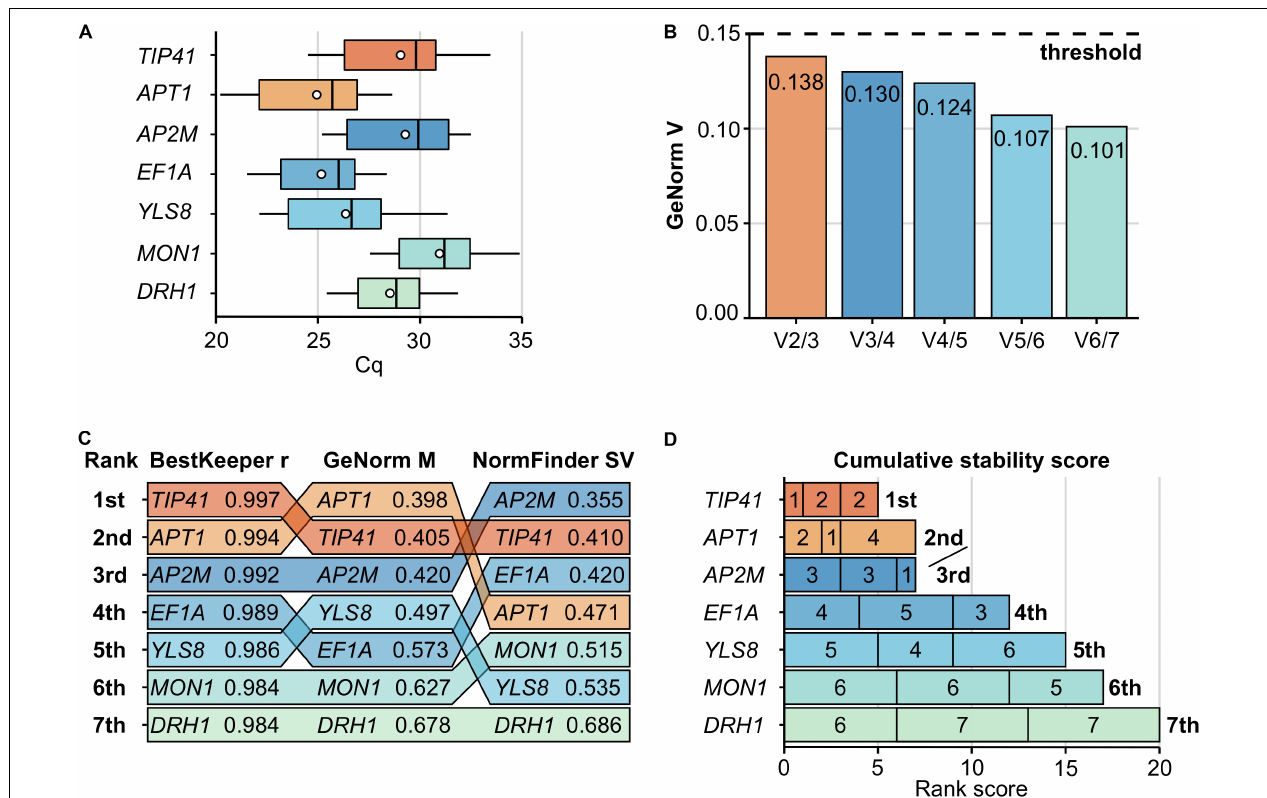
FIGURE 2 | Determination of the optimal set of reference genes during a pilot study. The expression stability of seven candidate genes ( TIP41 , APT1 , AP2M , EF1A , YLS8 , MON1 , and DRH1 ) was assessed during an independent pilot study. Samples harvest, total RNA extraction and RT-qPCR assays were performed similarly to the defense genes expression study, with 20 biological replicates and 3 technical replicates. (A) Cq values distribution per gene are presented on boxplots with the interquartile range as a box, the lowest and highest values as whiskers, the median as an inner line and the mean as a dot. (B) The determination of the optimal number of reference genes is based on GeNorm pairwise variation values (V n / n + 1 ). As V 2 / 3 (highlighted in orange) dropped below the commonly used 0.15 threshold (dashed line), two reference genes should suffice. (C) Expression stability values from BestKeeper (r), GeNorm (M) and NormFinder (SV) are presented for each gene, ranked from the most stable gene (1st, top) to the least stable (7th, bottom). Lower GeNorm and NormFinder values and higher BestKeeper value indicate more stable expression. (D) The final determination of the most stable reference genes is based on their low cumulative stability score, which is the sum of their ranks obtained from the three methods used (rank values inside bars, from left to right: BestKeeper, GeNorm, and NormFinder). The optimal set of reference genes (a pair formed by TIP41 and APT1 ) is highlighted in orange across all panels.